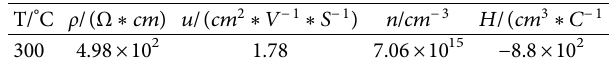
Table 2: Resistivity, mobility, carrier concentration, and Hall coefficient of the films after heat treatment at 300 ° C for